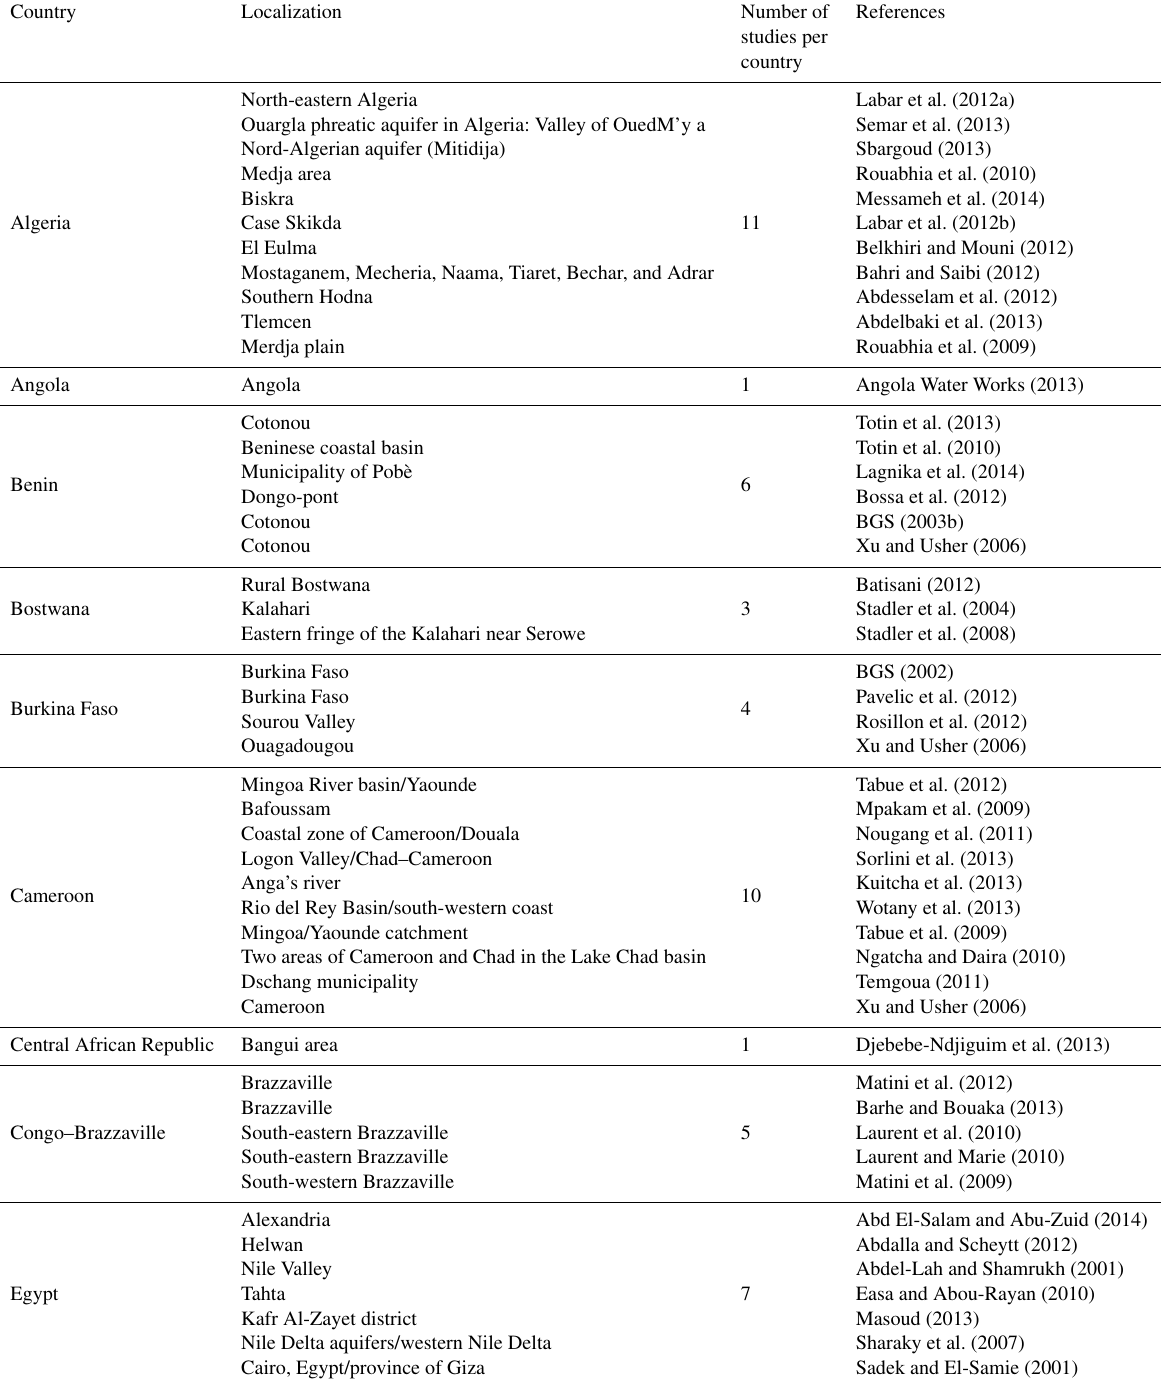
Table 2. Localization of study sites considered in the